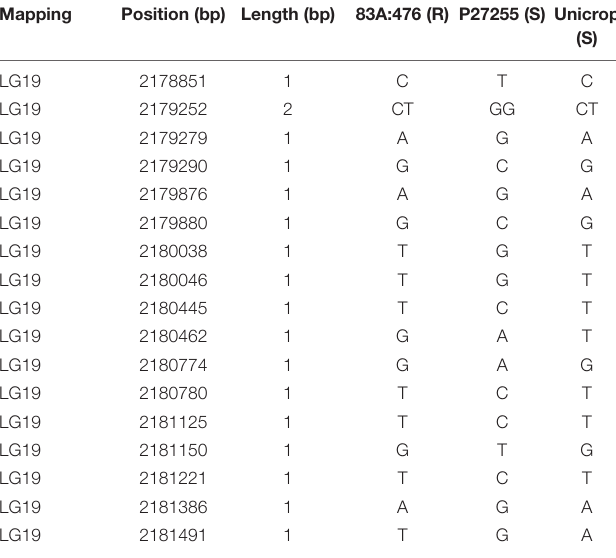
TABLE 3 | Variations in the gene LOC109334327 region.